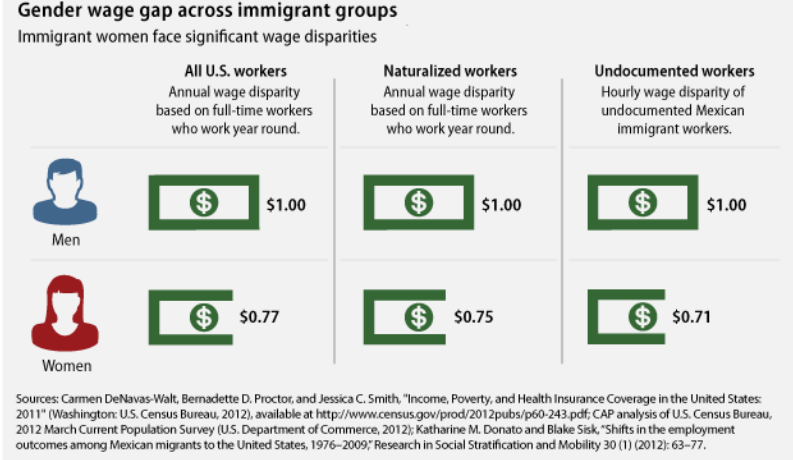
Figure 1. Gender pay gap image from Martha’s lesson.